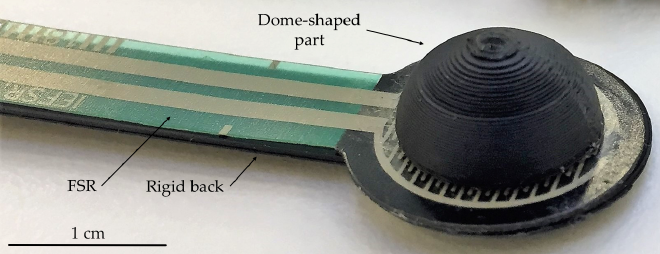
Figure 5. FSR with 3D-printed mechanical modifications for measuring contractions of the temporal muscle. The rigid back fixates the rear and the dome-shaped part distributes the applied force on the sensor’s active